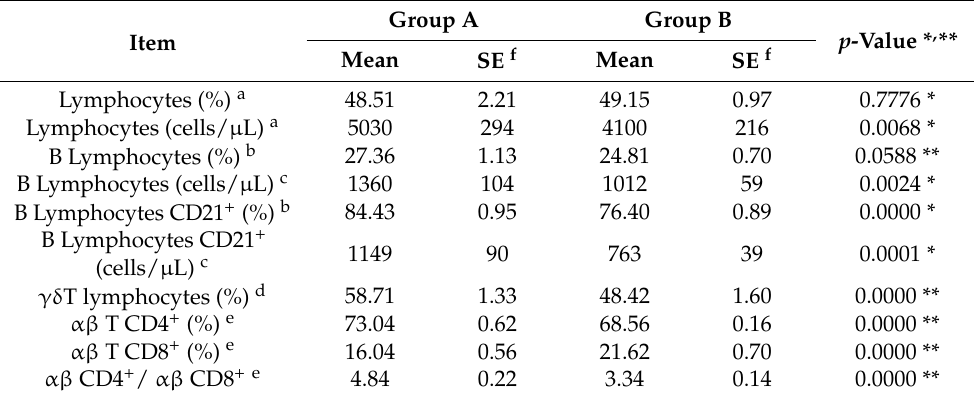
a Percentages and absolute values obtained by Cell Dyn 3700 SL.; b Percentages of CD79a + positive cells obtained by two-color flow cytometric panel.; c Absolute values of CD79a + or CD21 + subset estimated by multiplying flow